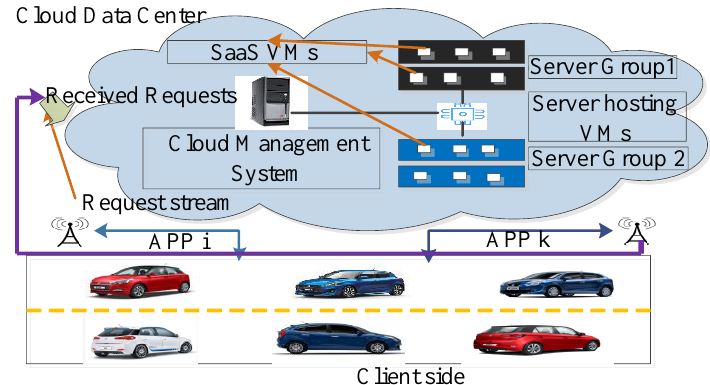
Figure 18. Heterogeneous IoT client sending various requests to a public cloud.